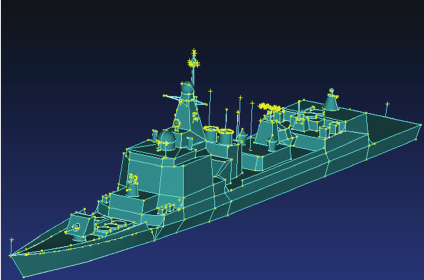
Figure 5: Ship model using FEMAP Destroyer ( 𝐿 × 𝑊 × 𝐻 (m): 154.0 × 17.0 × 6.0).